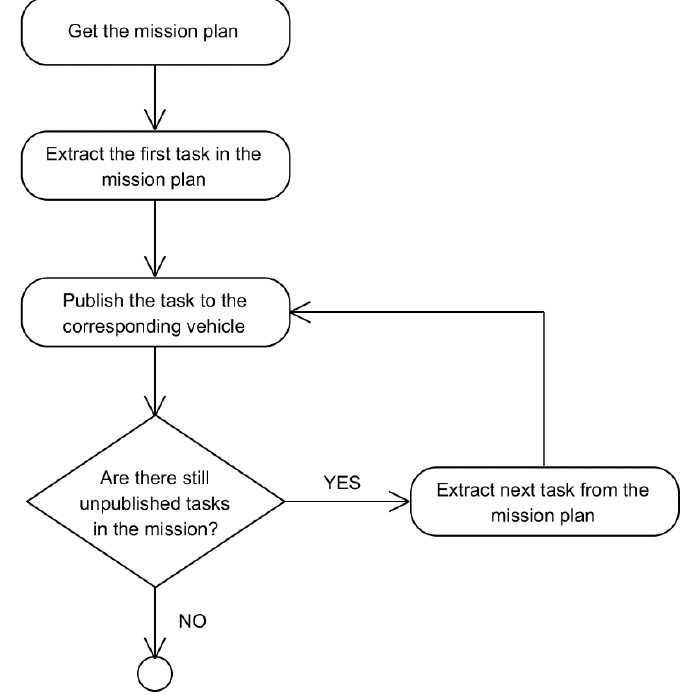
Figure 13. Flow diagram for the task assignment when done by full plan. The full sequence diagram is detailed in Figure 14.